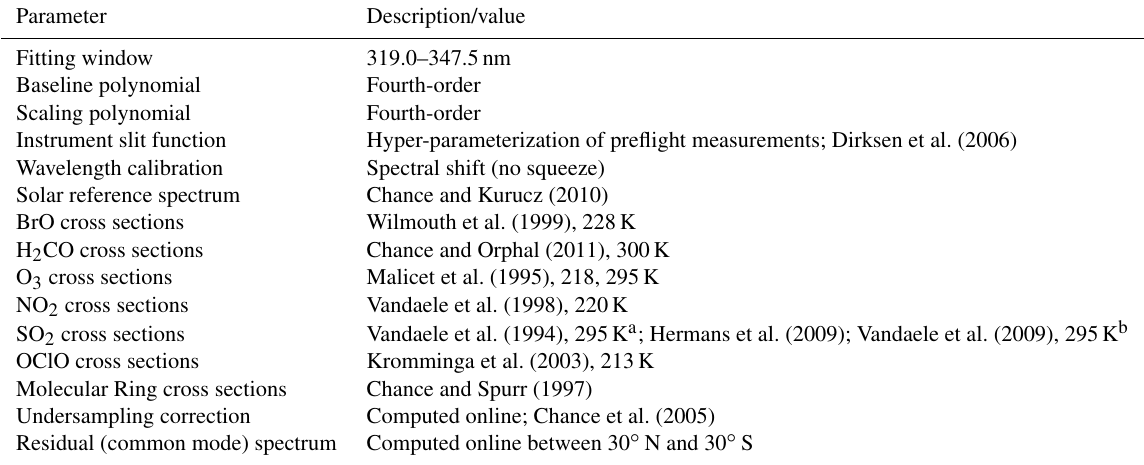
Table 1. Fitting window and parameters used to derive BrO vertical column